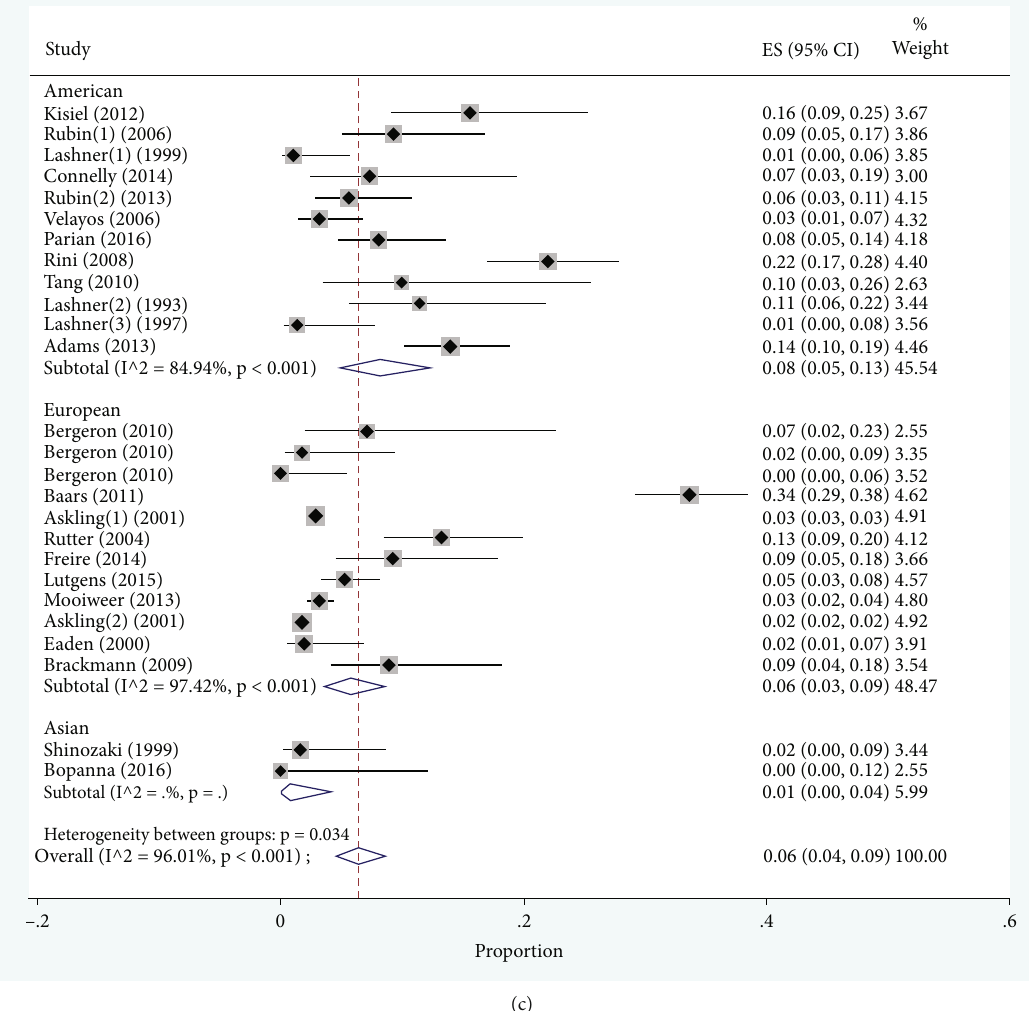
Figure 2: Forest plot for the prevalence of family history of CRC among IBD patients: (a) overall prevalence; (b) prevalence by degree of relative; (c) prevalence by region of